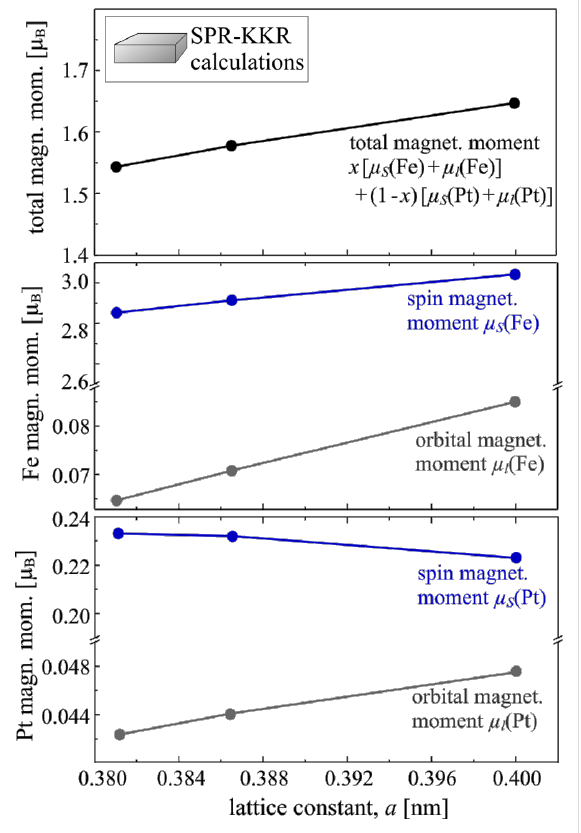
Figure 9: Dependence of spin and orbital magnetic moments at the Fe and Pt sites in chemically disordered FePt alloys for different lattice constants calculated using the SPR-KKR method (x =